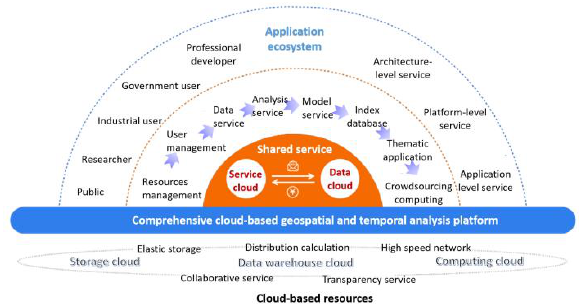
Figure 1. Architecture of the comprehensive cloud-based geospatial and temporal analysis platform